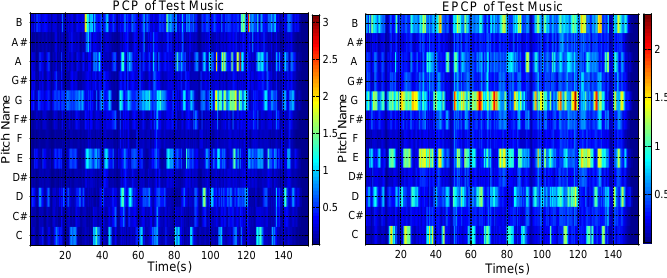
Figure 4. PCP ( left ) and EPCP ( right ) of test music. Appl. Sci. 2016 , 6 , 157